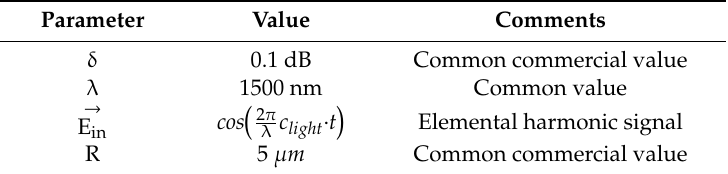
Table 1. Selected values for the Lyapunov numerical study.